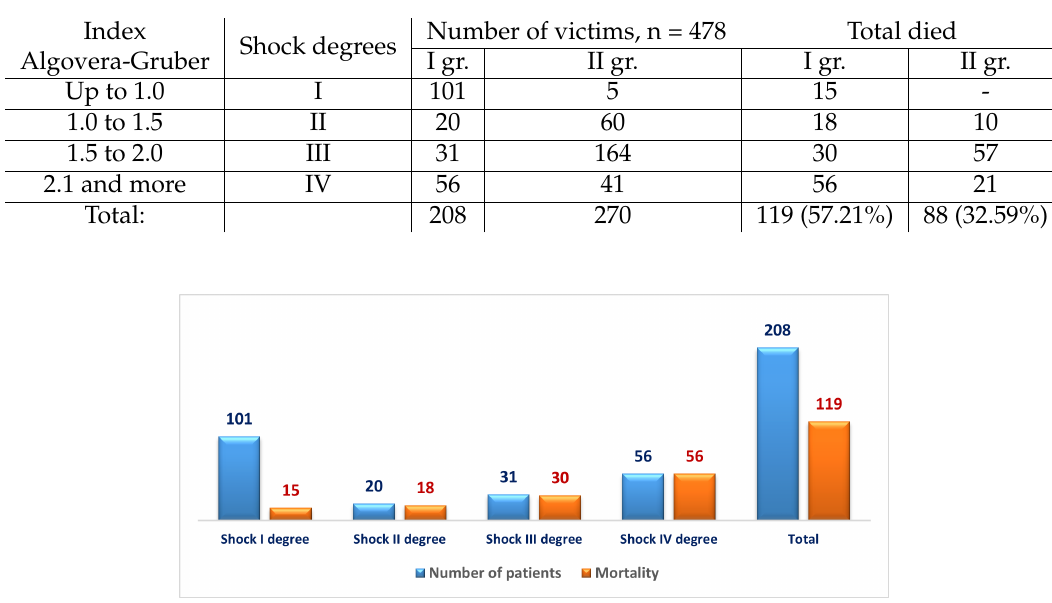
Figure 8. Dependence of the mortality rate on the degree of shock in the control group, n = 208.